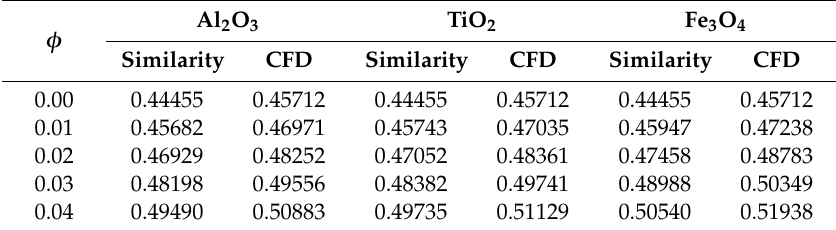
Table 2. Variation of Re 1/2 x C f with φ .